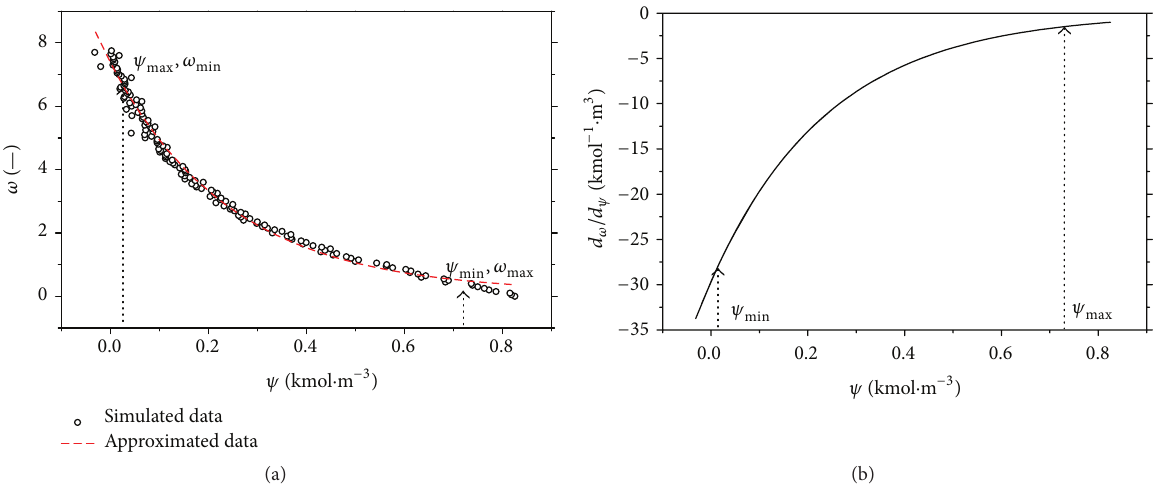
Figure 8: The simulated and approximated steady-state characteristic in new coordinates (a) and the course of the derivative of 𝑑𝜓/𝑑𝜔 (b).